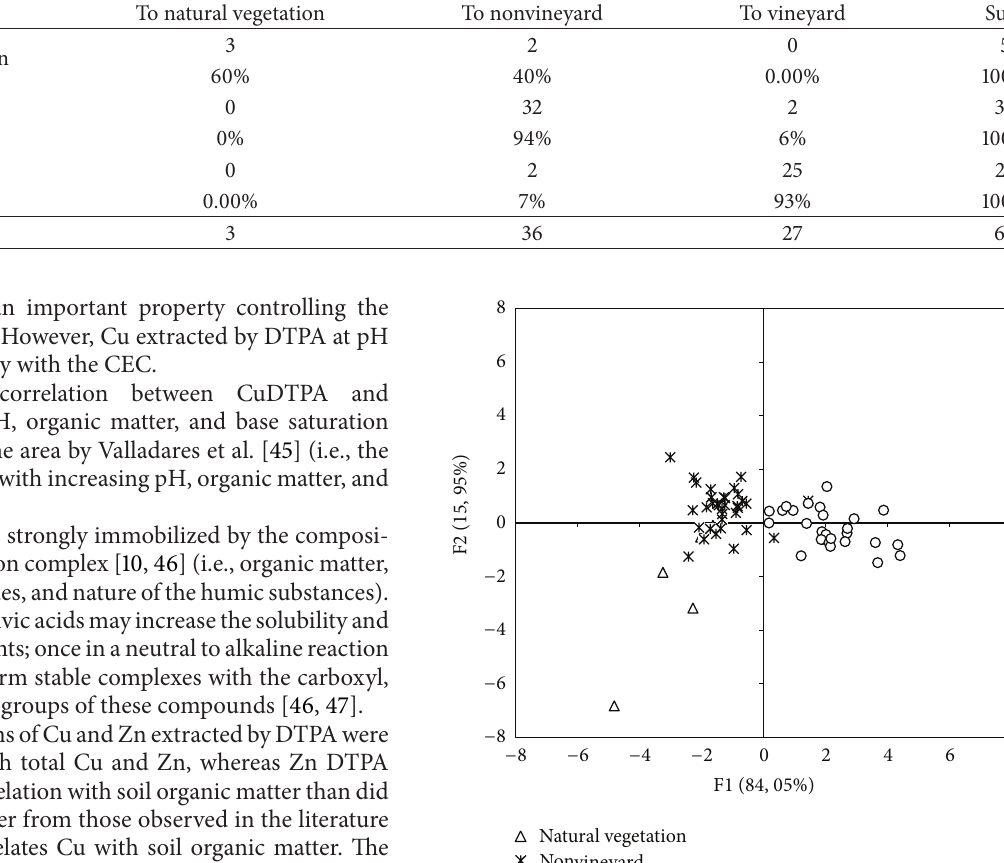
Table 4: Confusion matrix of land use classifications based on discriminant analysis.